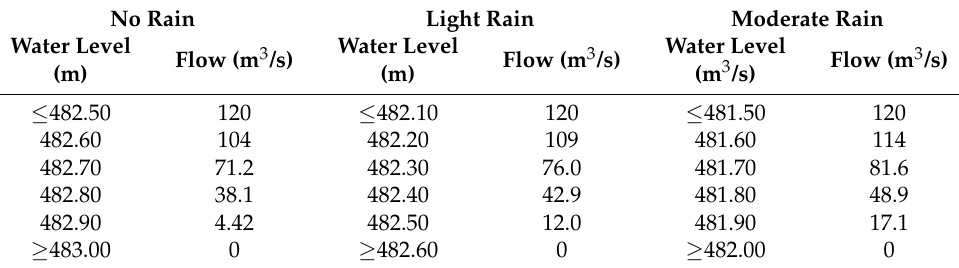
Table 7. Maximum replenishment ecological